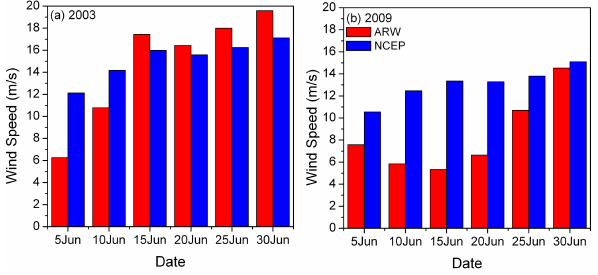
Figure 9. Rainfall in June over India and over each rainfall zone (Z1, Z2... Z7) from model, NNRP reanalysis and IMD gridded rainfall for (a) 2003 and (b) 2009.